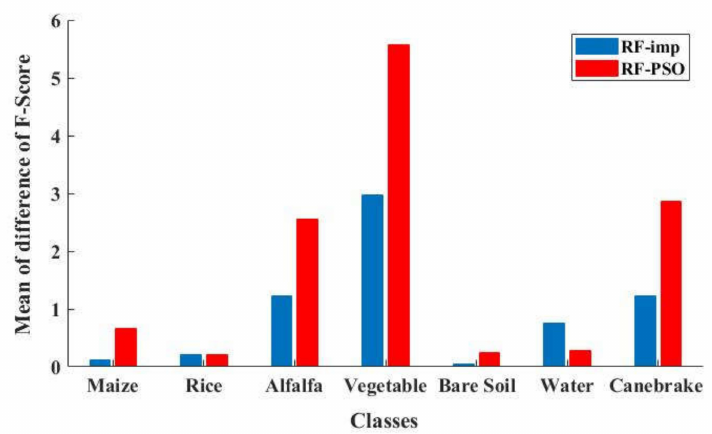
Figure 5. Mean of di ff erence of F-score between RF-PSO and RF, RF-variable importance measure (RF-imp), and RF methods in each class for all feature